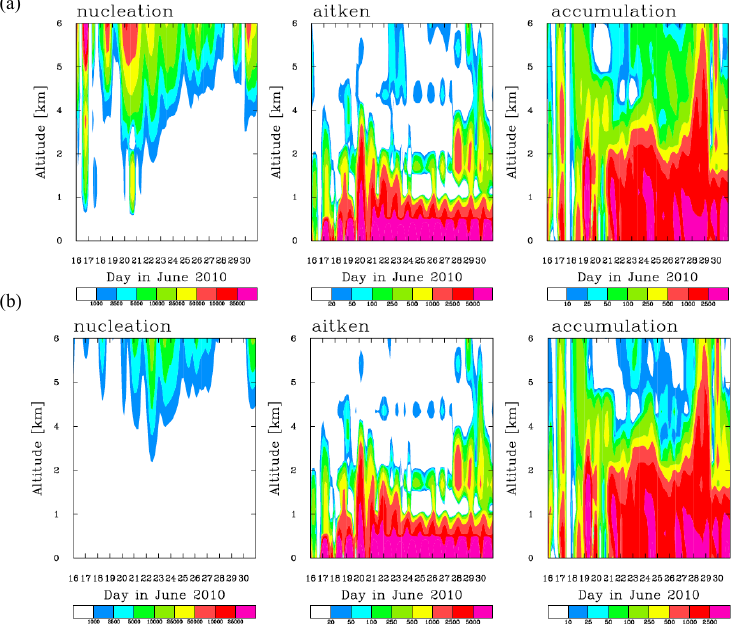
Fig. 9. Modelled vertical profiles of particle number concentration in the nucleation (left column), Aitken (middle column) and accumulation Figure 9. Modeled vertical profiles of particle number concentration in the nucleation (left 17 mode (right column) at Puy-de-Dôme in cm − 3 during June 2010 (a) with LV-SOG nucleation and (b) without LV-SOG column), Aitken (middle column) and accumulation mode (right column) at Puy-de-Dôme in 18 1/cm 3 during June 2010 (a) with LV-SOG nucleation and (b) without LV-SOG nucleation. 19